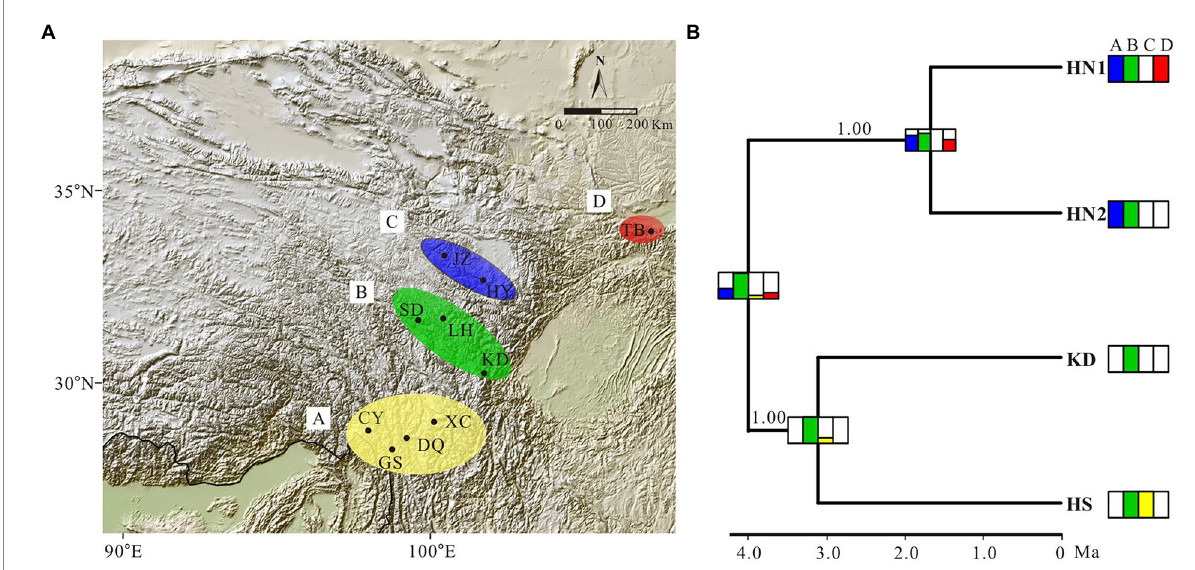
FIGURE 5 Ancestral area estimation of the Gentiana hexaphylla complex based on BioGeoBEARS. (A) Area definition for ancestral area estimation, based on the extant distribution of the G. hexaphylla complex. (B) Ancestral range estimation based on BAYAREALIKE model implemented in BioGeoBEARS based on the result from BEAST. Extant species distributions used for the ancestral area estimations are provided in coloured boxes next to each lineage. Boxes on each node represent the cumulative probabilities for the estimated ancestral range. Phylogenetic support values for Bayesian inference are shown on